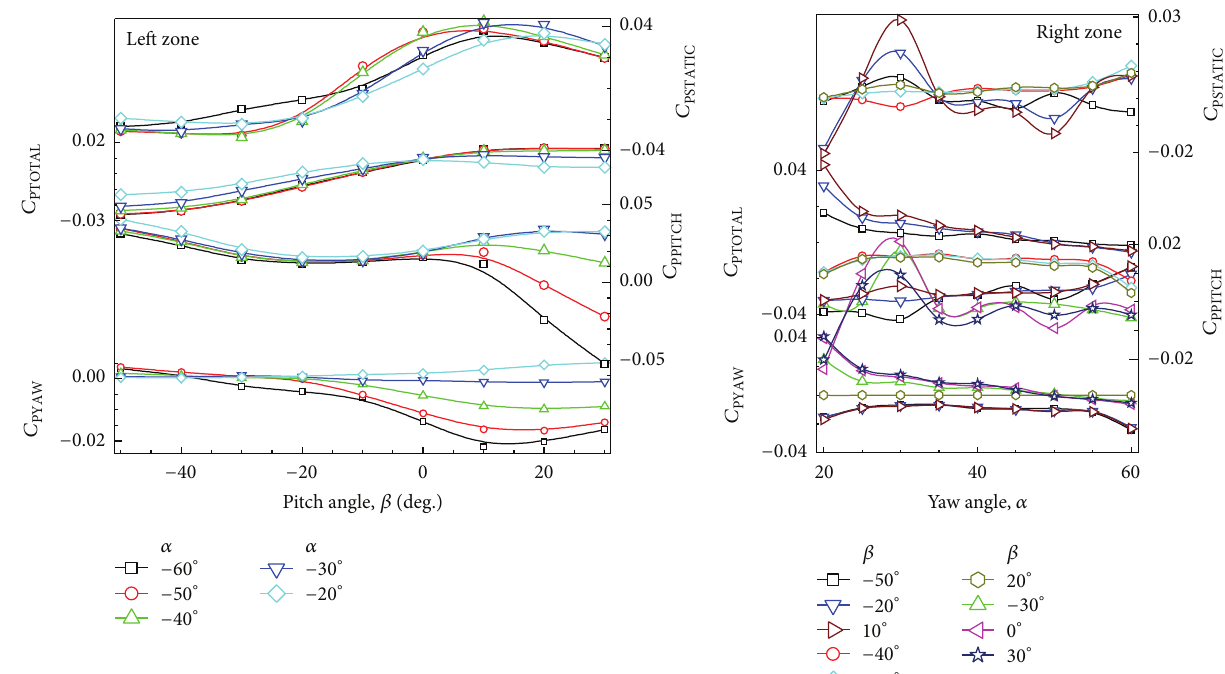
Figure 9: Sensitivity curves of the calibration coefficients in the left and right